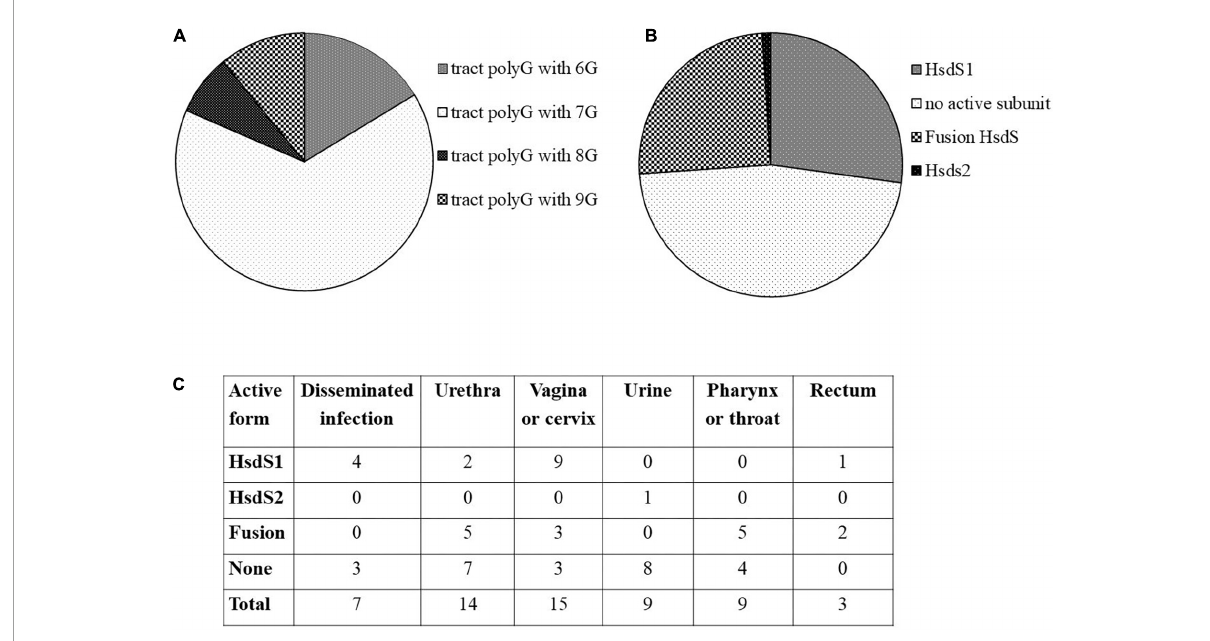
FIGURE1 In silico analysis of ngoAV locus present in sequenced genomes of gonococci from NCBI database. (A) Distribution of the number of guanines (G) in the polyG tract. (B) Distribution of probable active and non-active forms of MTase forming subunits. (C) Number of strains according to their isolation site and the probable form of NgoAV-like